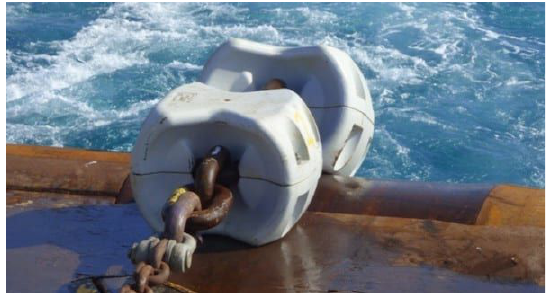
Figure 3. Typical clumped weight used in the offshore industry.